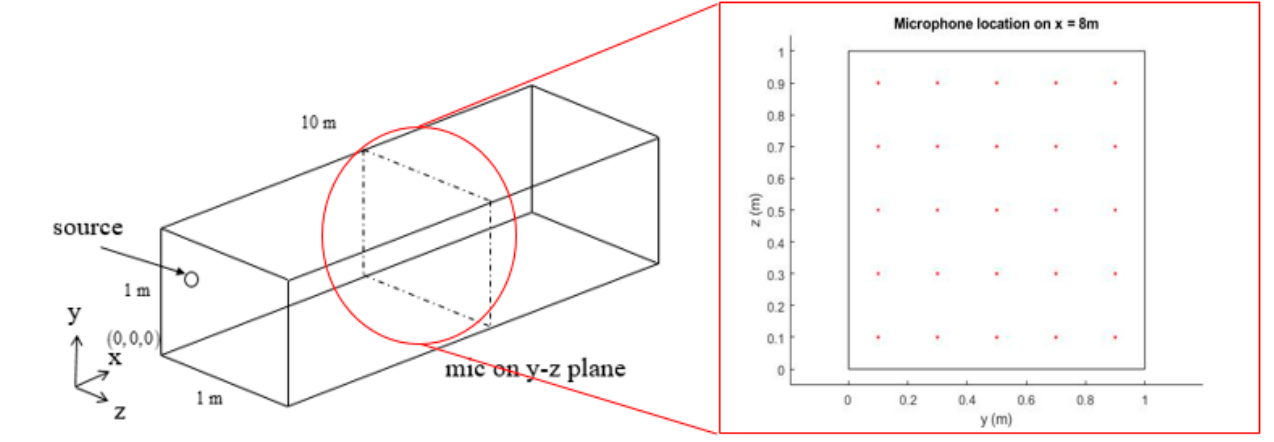
Figure 7. Microphone configuration in the rectangular cuboid model.